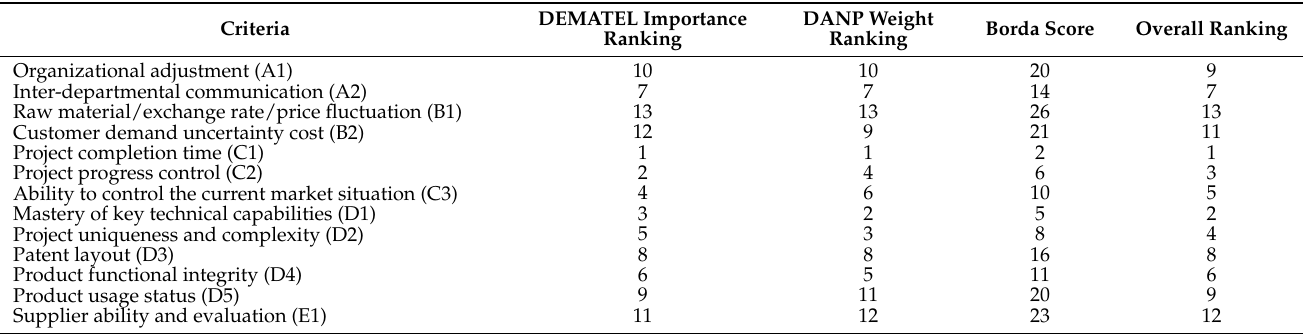
Table 10. Total influence matrix that determines the mutual influence relationship among key influence criteria.